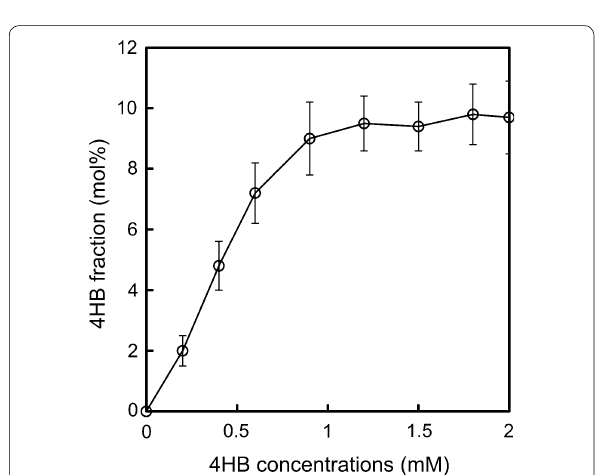
Fig. 4 4HB fractions in P(3HB- co -4HB) produced relative to initial 4HB concentrations. The primary carbon substrate is CH 4 . The errors bars represent standard deviations for triplicate batch